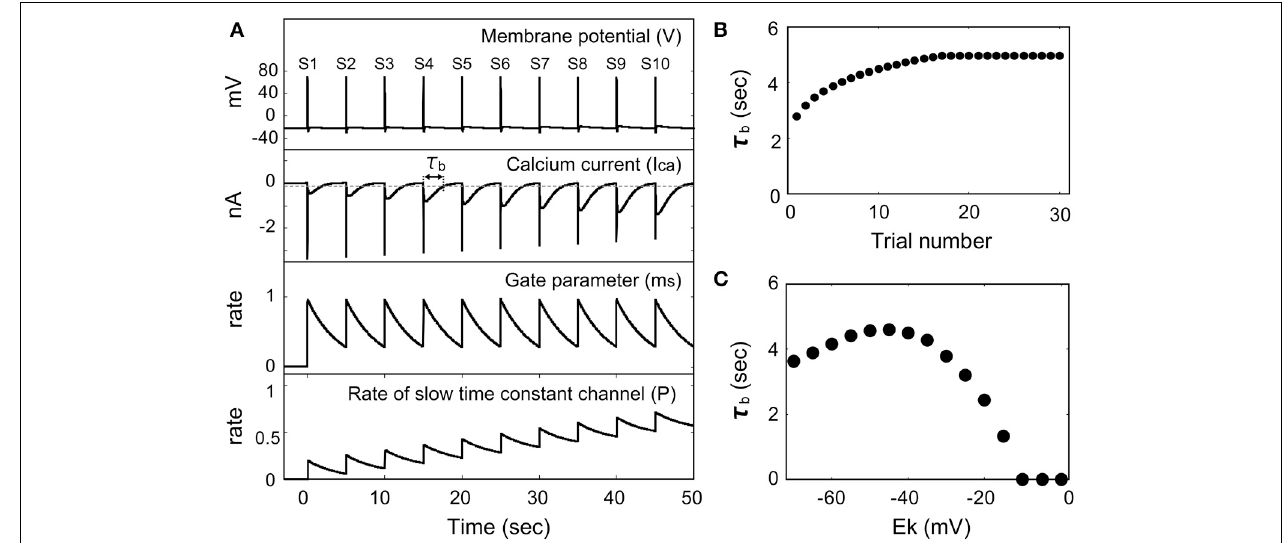
FIGURE 4 | Membrane potential response induced by a periodic outward flow of current in the presence of a Ca 2+ channel with the slow time constant. (A) Time dependence of the membrane potential, Ca 2 + current, gate parameter ( m s ), and the rate of the